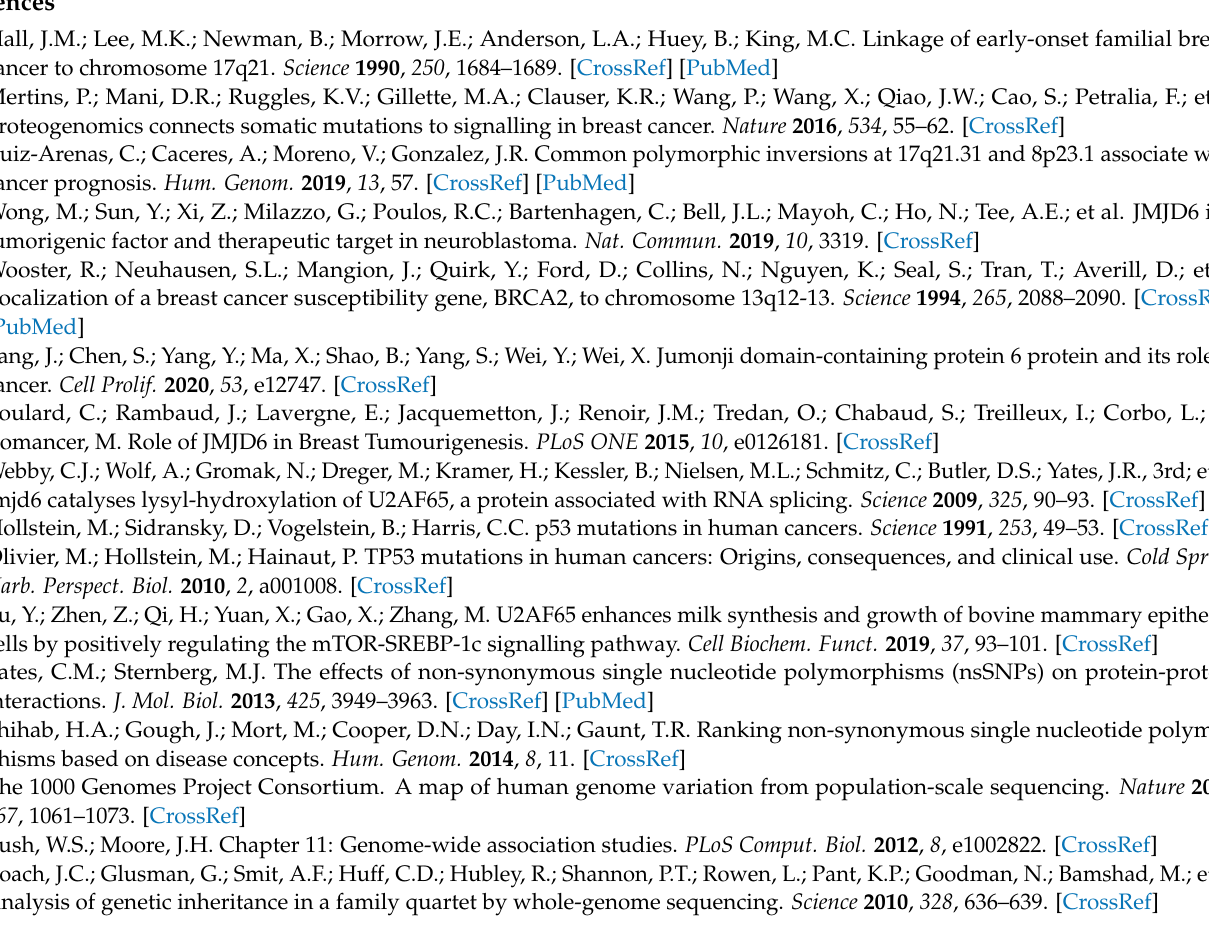
across species. Figure S2: Protein structure homology modeling of JMJD6. Figure S3: SDS-PAGE gel image. Table S1: List of nsSNPs in JMJD6 and the results of the computational analysis. Table S2: List of the identified